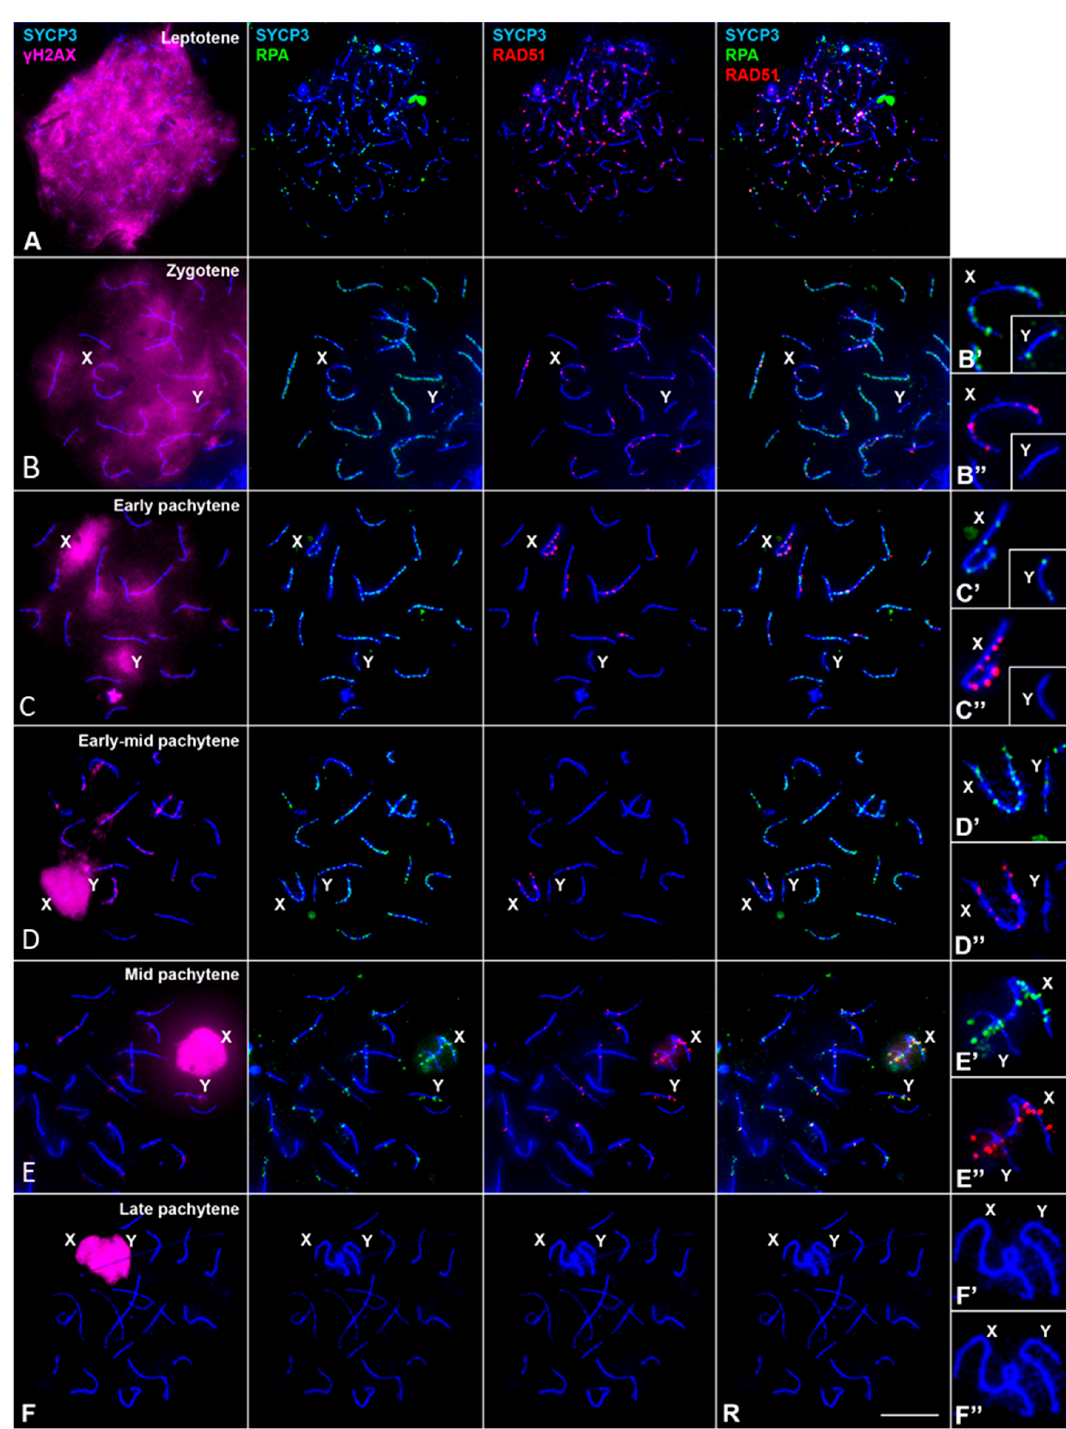
Figure 4. Distribution of RPA and RAD51 during prophase-I in spermatocyte spreads. First column on the left: SYCP3 (blue) and γ H2AX (magenta); second column: SYCP3 (blue) and RPA (green); third column: SYCP3 (blue) and RAD51 (red); fourth column: SYCP3 (blue), RPA (green) and RAD51 (red); right column: enlarged details of sex chromosomes for each row. Staging was determined according to SYCP3 and γ H2AX labelling patterns, in agreement with Figure 2. ( A ) Leptotene: RPA and RAD51 foci are observed throughout the nucleus associated to forming AEs. ( B ) Zygotene: RPA foci are distributed along synapsed and unsynapsed regions of chromosomes. RAD51 foci are less abundant and mainly localize to unsynapsed regions. Some foci overlap while others do not. Sex chromosomes are distinguishable. The X chromosome shows abundant RPA and RAD51 foci, but the Y chromosome only shows a few RPA foci and rarely accumulates